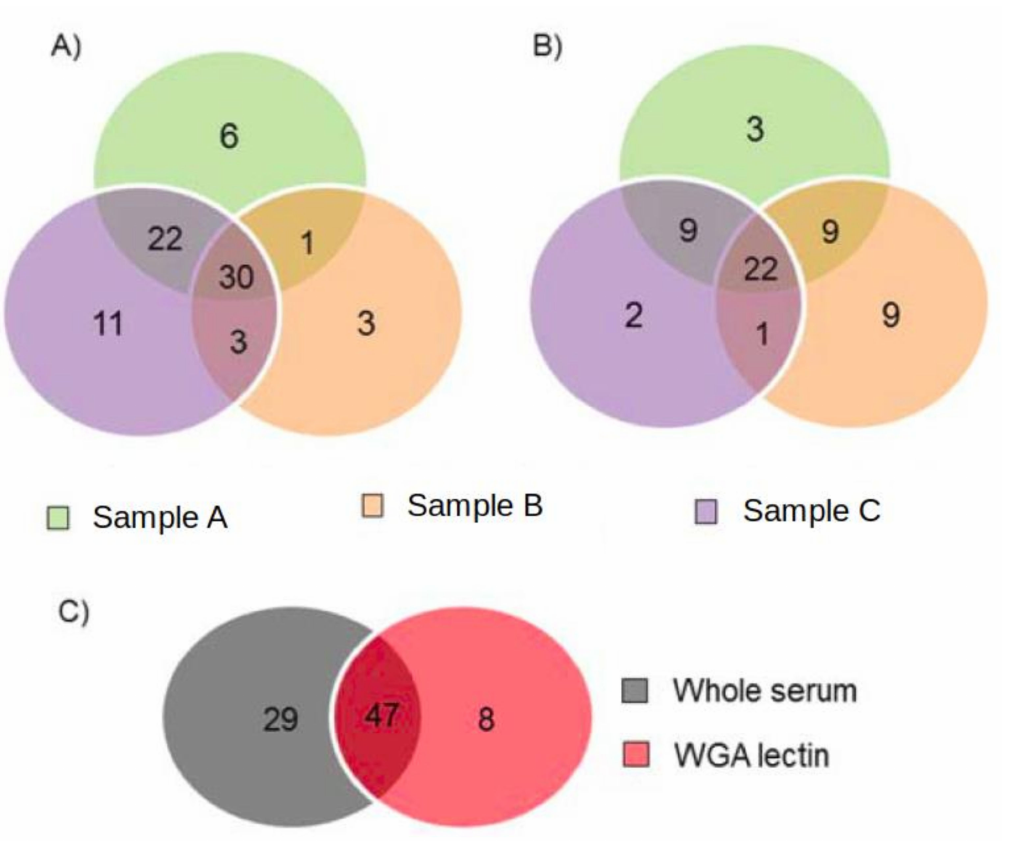
Figure 1. Venn diagram comparison of the identified proteins. ( A ) Whole serum samples. ( B ) Samples processed by WGA lectin. ( C ) Serum samples vs. samples processed by WGA